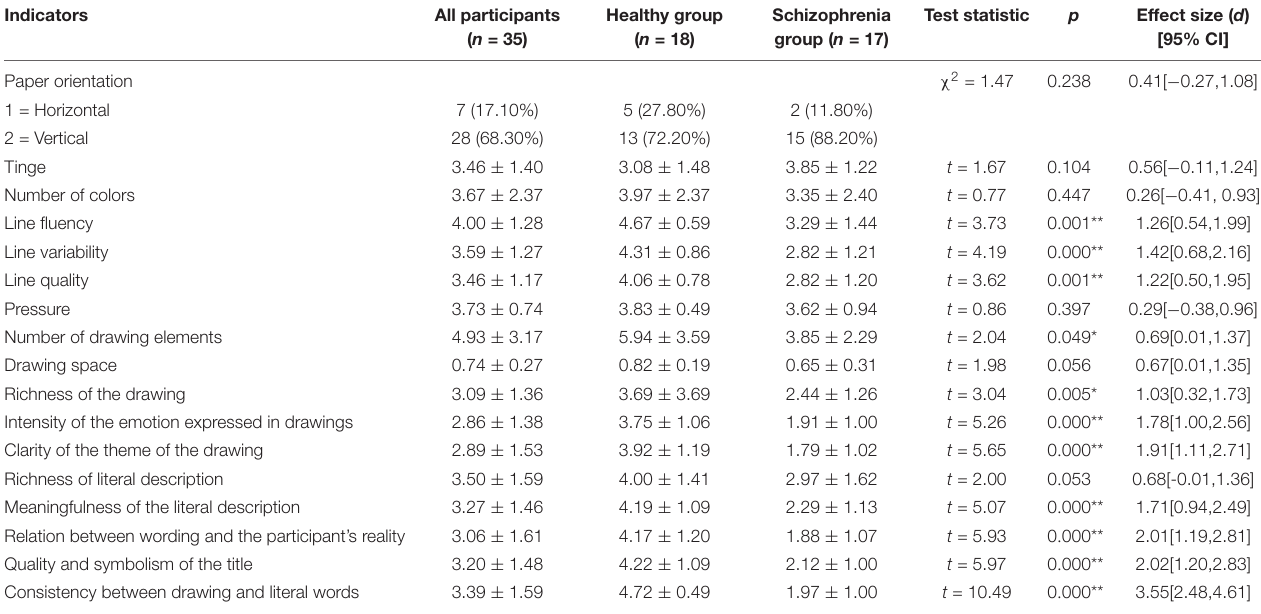
TABLE 6 | Comparison of drawing coding results among different groups.